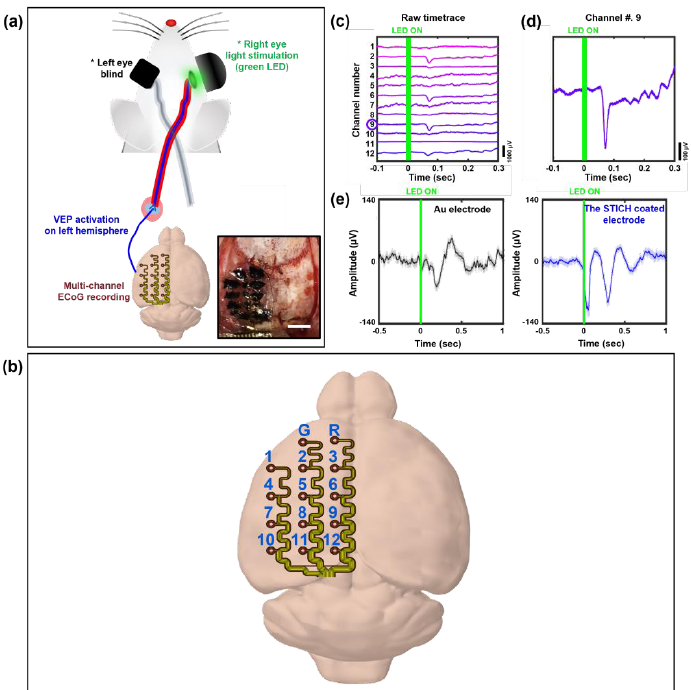
Figure 6. Experimental results of the acute in vivo ECoG monitoring and VEP activation tests con- ducted using an anesthetized rodent model. ( a ) Schematic of ECoG monitoring during VEP activa- tion on the left hemisphere of a rat by stimulating its right eye using a green LED (inset: a photo- graph of the STICH − coated stretchable surface electrode arrays mounted on the left hemispheric cortex, the scale bar indicates 3 mm). ( b ) Two − dimensional deployment map of the multi − channel ECoG electrodes mounted on the rodent’s cortex. ( c ) Representative raw plot of the baseline ECoG and VEP signals recorded using the multi − channel surface electrode arrays. ( d ) An activated VEP signal recorded from a representative channel. ( e ) Average VEP plot derived from 140 trials of light stimulation tests. The difference in amplitude of the average VEPs before (left) and after (right) the STICH coating demonstrates the significant contribution of the STICH in improving the neural re- cording performance of the electrodes.